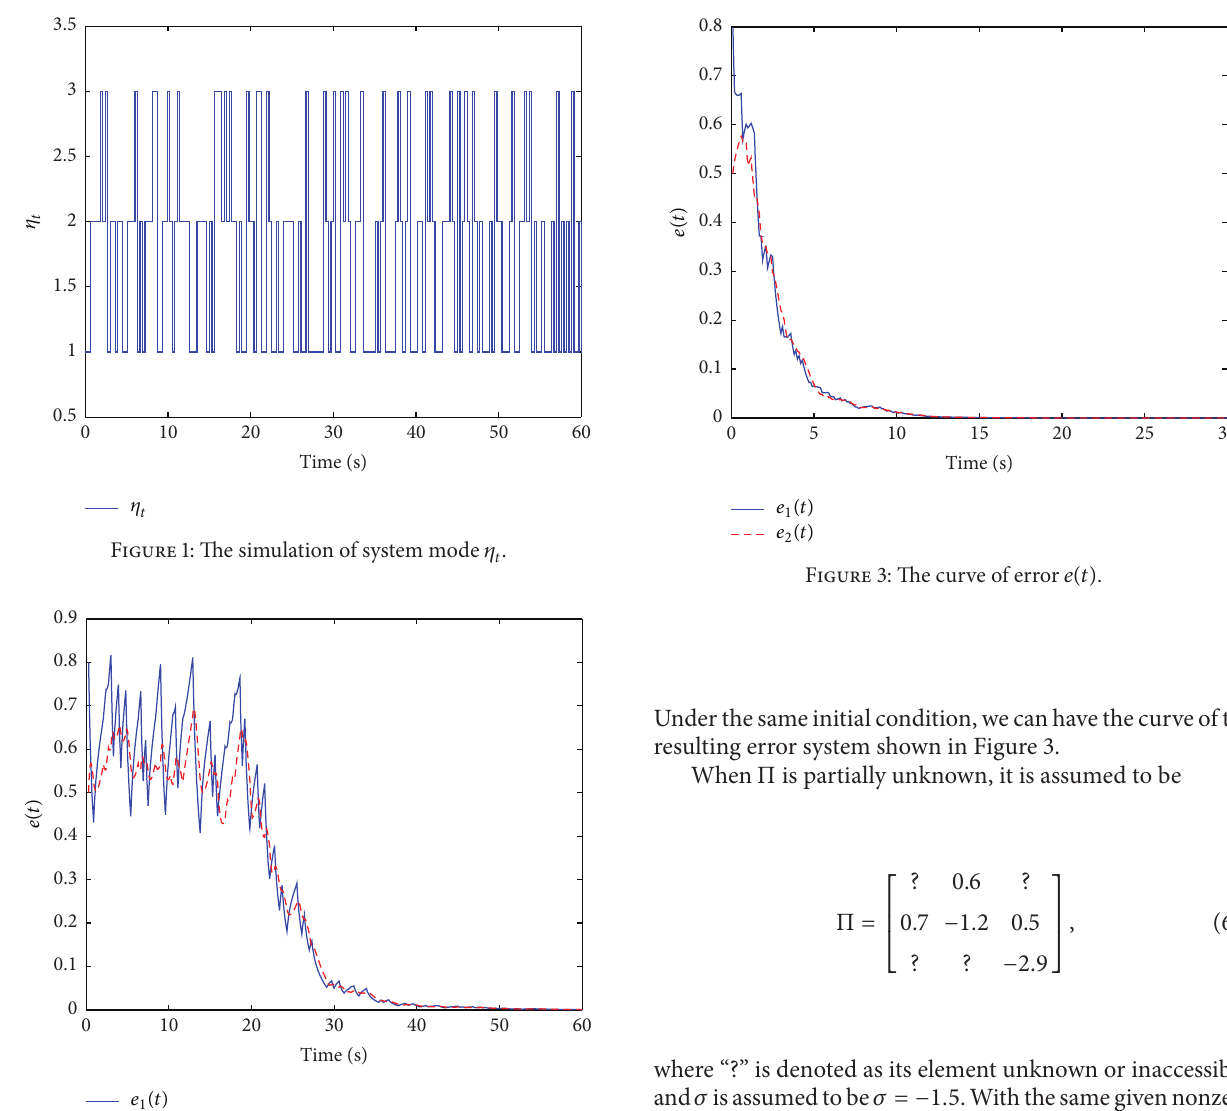
Figure 2: The response of error 𝑒(𝑡) .